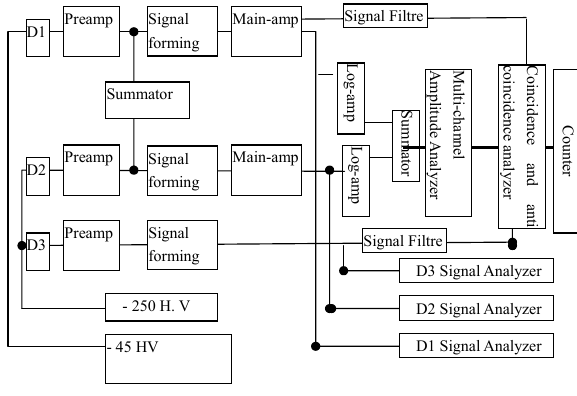
Fig. 4. Block diagram of